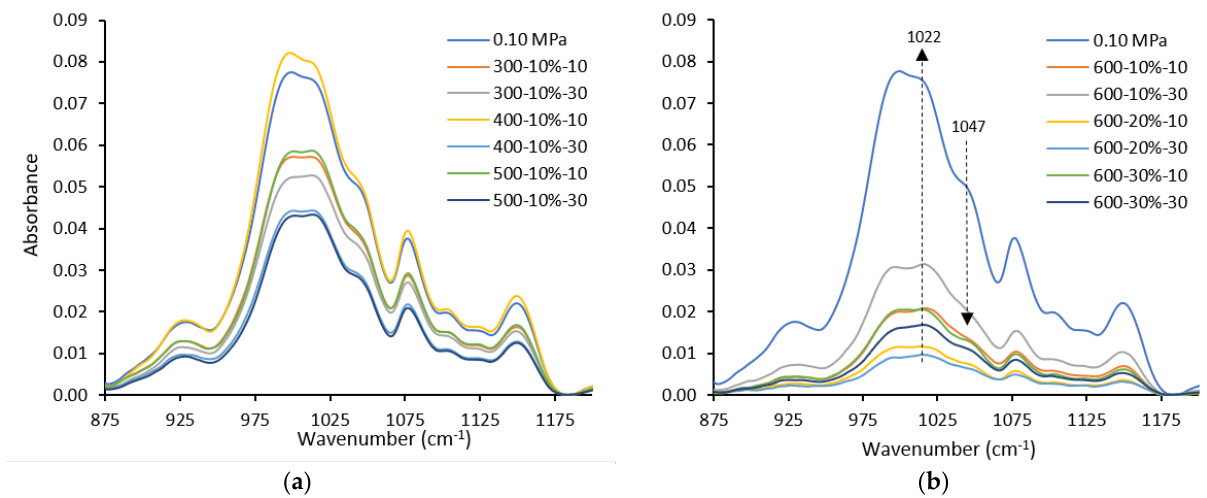
Figure 3. FTIR spectra of untreated (0.10 MPa) and selected HPP-treated flours at the 875 – 1200 cm − 1 region; ( a ) 0.01 MPa and 300 – 500 MPa – 10% flour concentration at both 10 and 30 mins; ( b ) 0.01 MPa and all 600 MPa combinations.